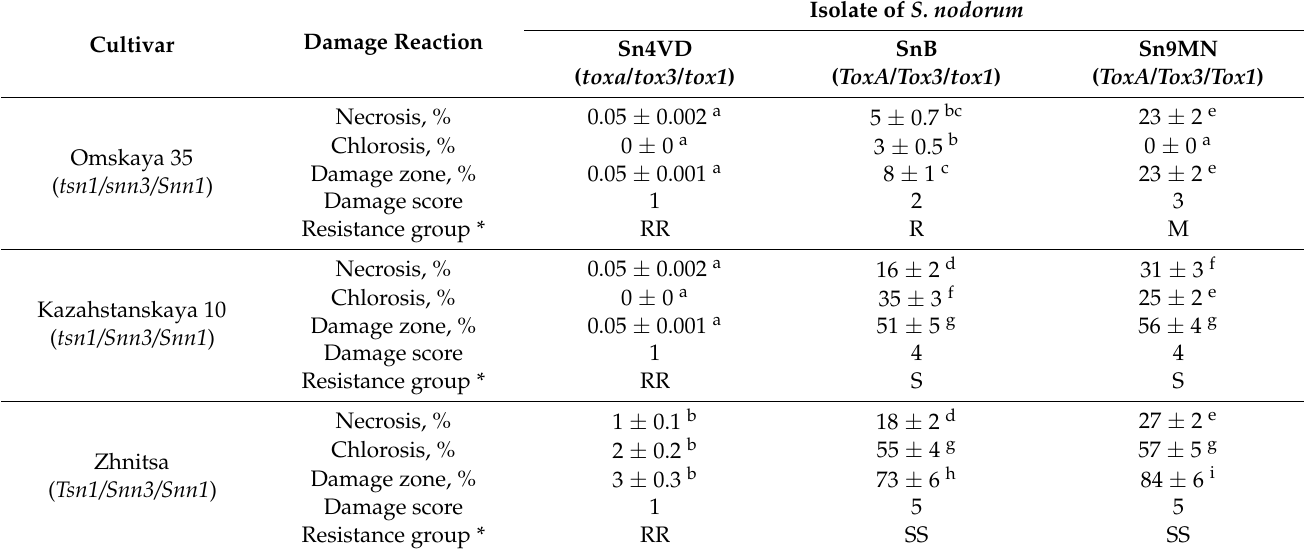
Table 2. Reaction of T. aestivum cultivars Zhnitsa, Kazakhstanskaya 10, Omskaya 35 with different allelic states of the Tsn1 , Snn1 and Snn3 susceptibility genes to inoculation with S. nodorum isolates Sn4VD, SnB and Sn9MN carrying a different set of NE genes SnToxA , SnTox3 and SnTox1